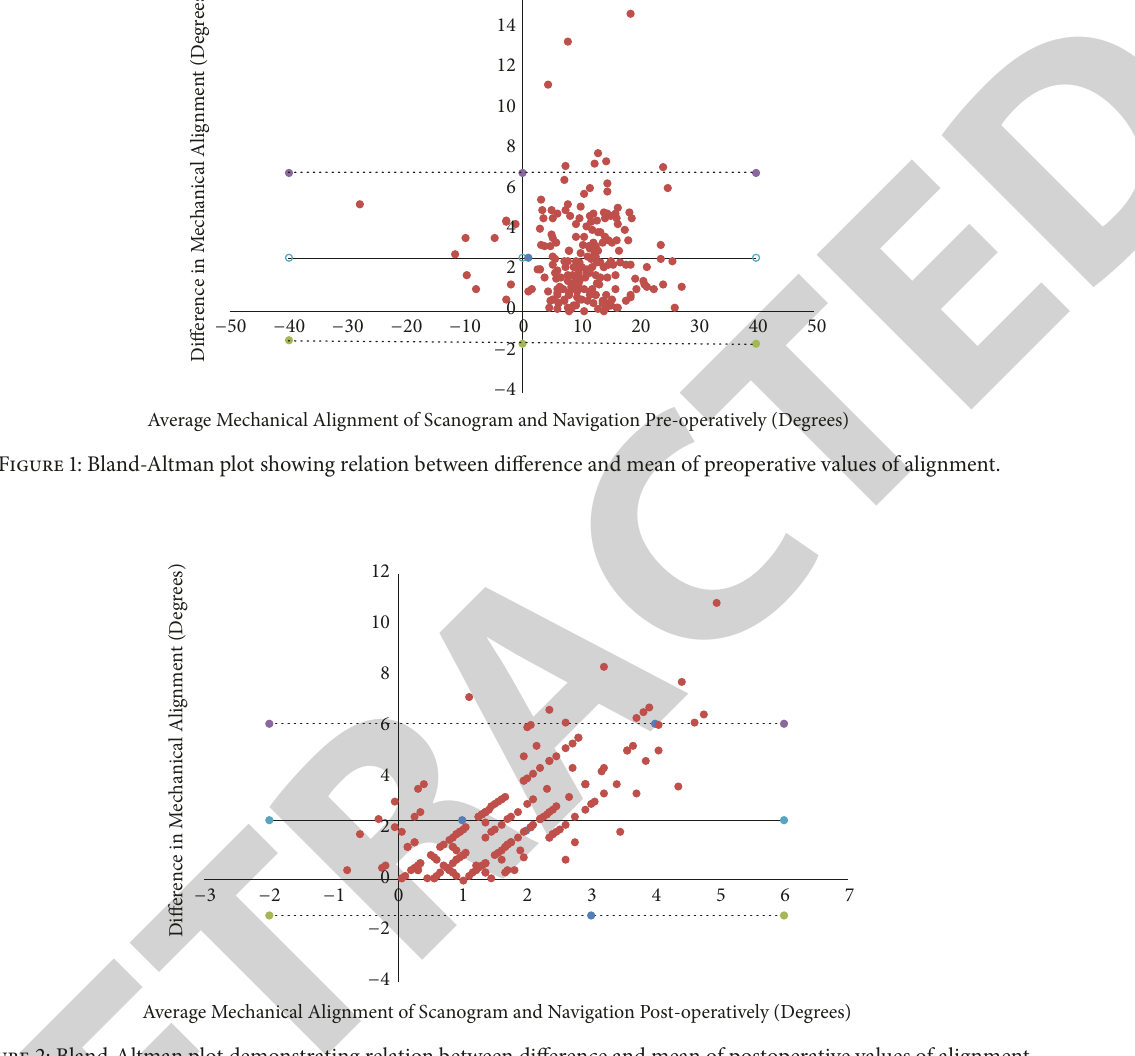
Figure 2: Bland-Altman plot demonstrating relation between difference and mean of postoperative values of alignment.